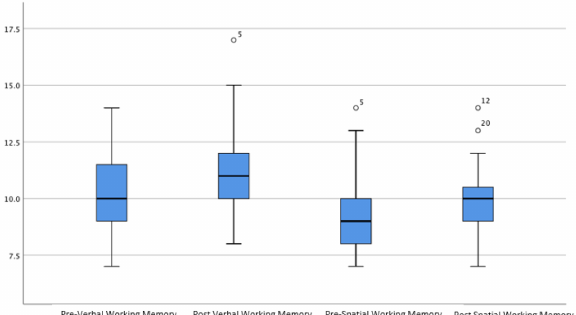
Figure 1. The mean in scaled score pre- and post-training for verbal and visuospatial working memory